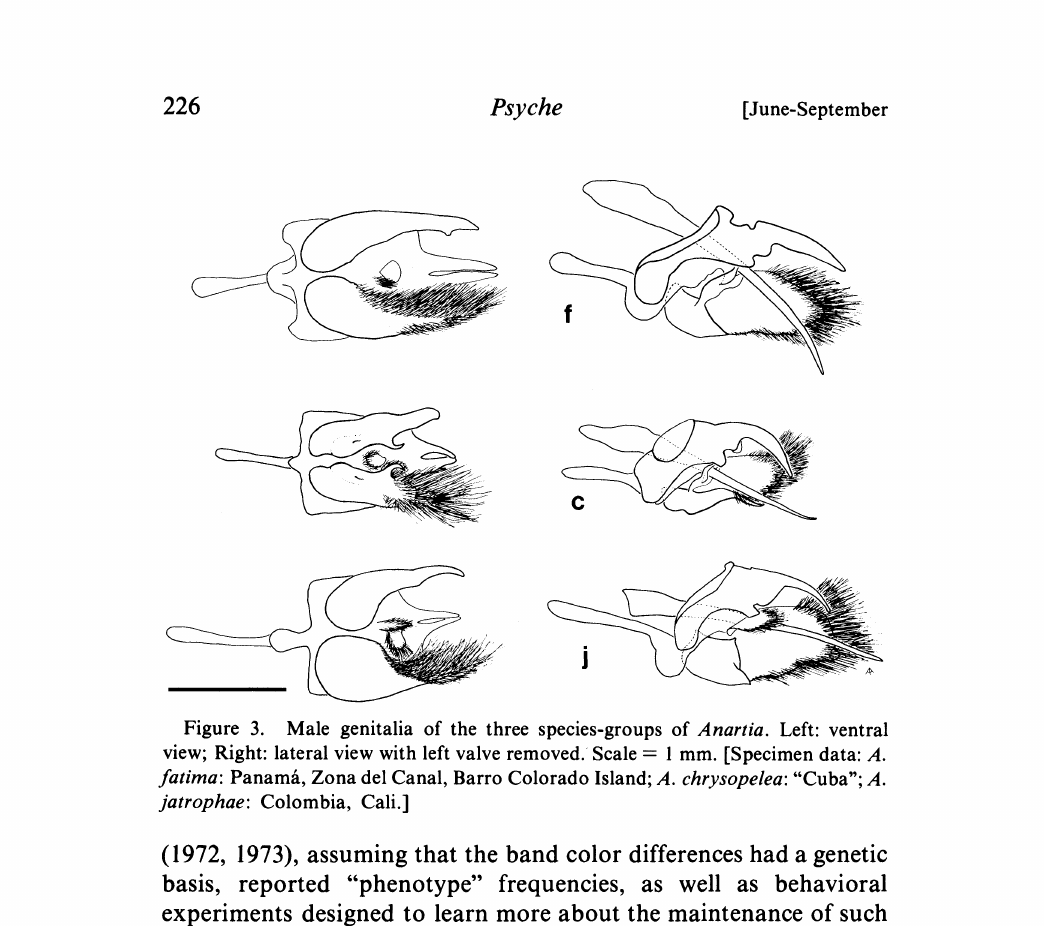
Figure 3. Male genitalia of the three species-groups of Anartia. Left: ventral view; Right: lateral view with left valve removed. Scale mm. [Specimen data: